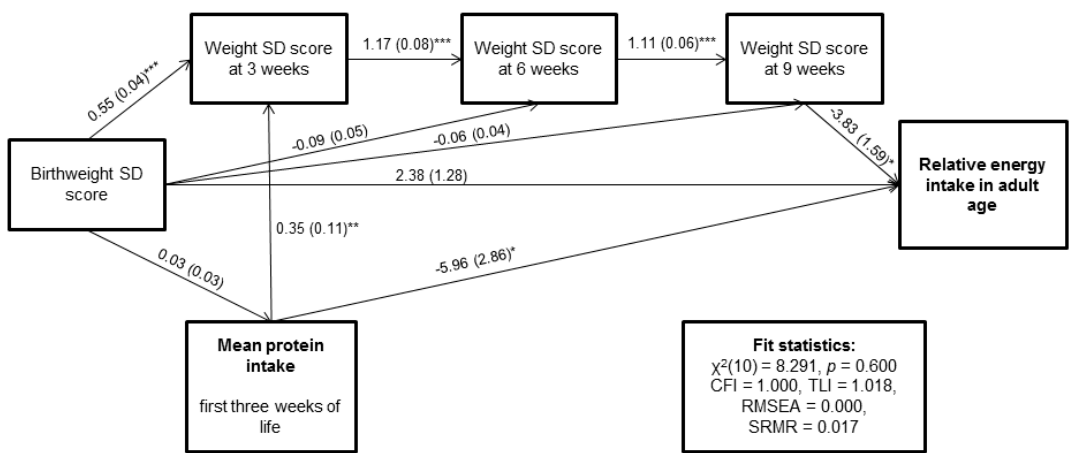
Figure 2. Graphical representation of path model estimated for protein intake during the first three weeks of life, body weight with four time points and relative energy intake in adult age ( n = 109). Paths represent path coefficient and standard error in parenthesis. Significance of estimated path is noted as * p < 0.05, ** p < 0.01 and *** p < 0.001. Abbreviations used: CFI Comparative Fit Index; RMSEA Root Mean Square Error of Approximation; SD Standard Deviation; SRMR Strandardized Root Mean Residual; TLI The Tucker-Lewis Index.